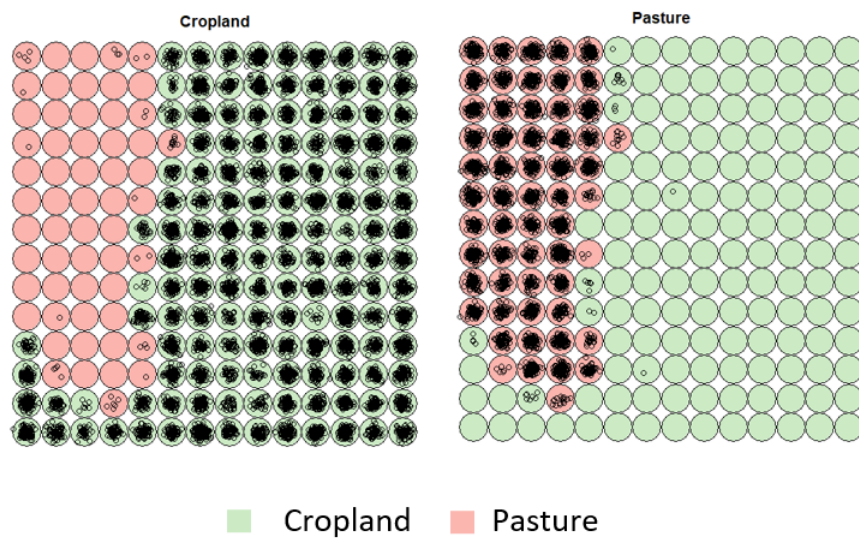
Figure 5. Mapping samples onto the SOM grid. Each dot represents a sample.